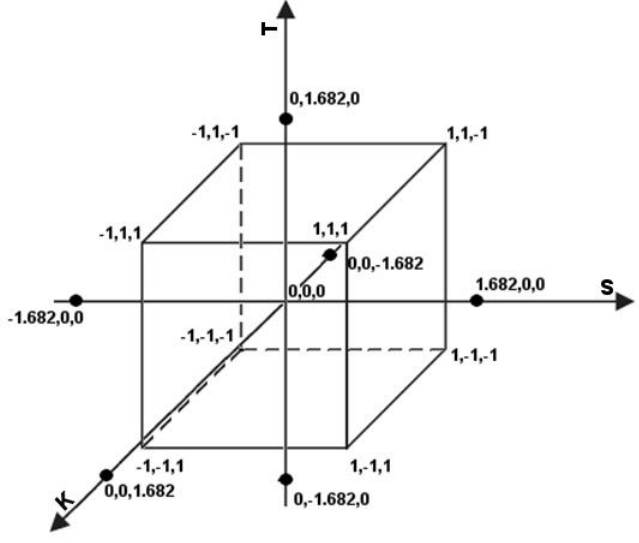
Figure 7. A graphical representation of the design of experiment in a simple 3-parameter experimental space. Table 4. Values of input parameters of the design of Table 5. Hartley’s five-level, three-factor, rotatable, orthogonal design of experiment with real values.